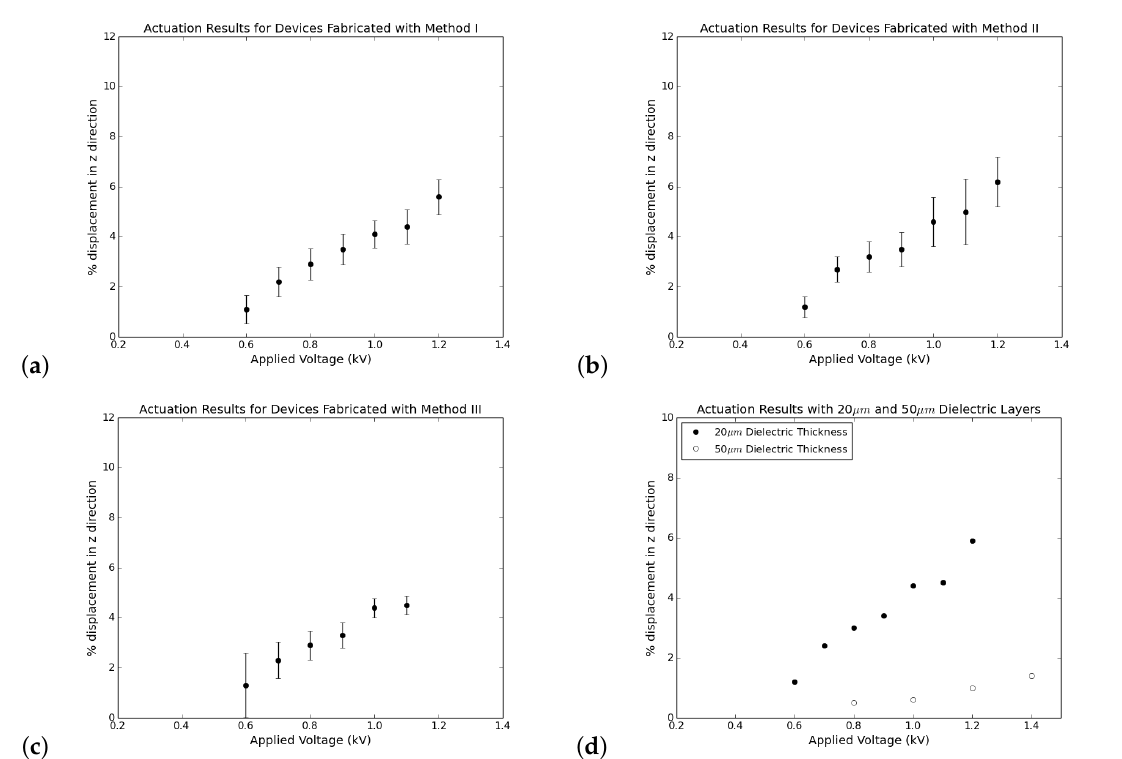
Figure 12. Actuation results for the devices fabricated through ( a ) Method I, ( b ) Method II, and ( c ) Method III. ( d ) The actuation ratios of devices with dielectric layer thickness of 20 and 50 µ m. Error bars indicate the standard deviation of the measurements in (a, b) and indicate instrument accuracy in